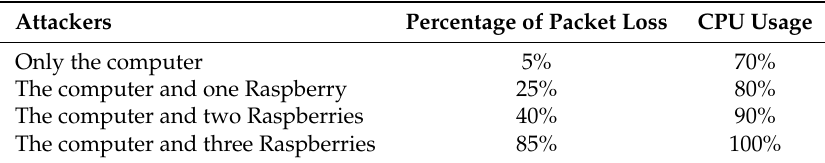
Figure 8. Ping response time vs number of attackers. Table 2. Percentage of discarded packets and CPU usage in the